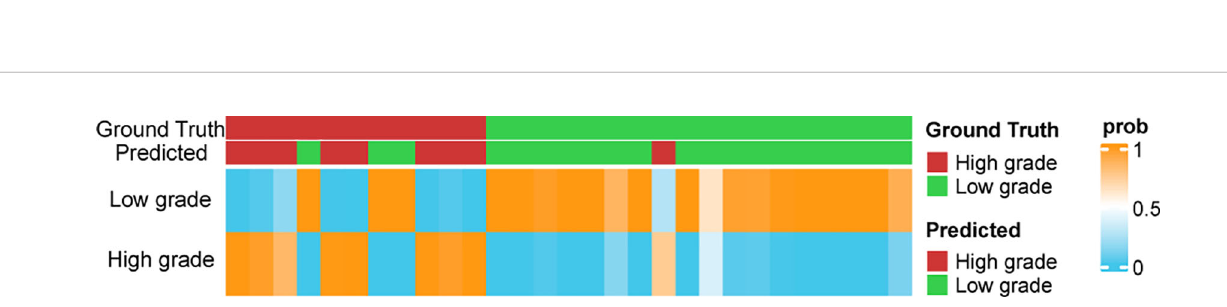
FIGURE 5 | The prediction probabilities assigned by the classi fi er in the validation set. The top annotation labels show the ground truth and the predicted